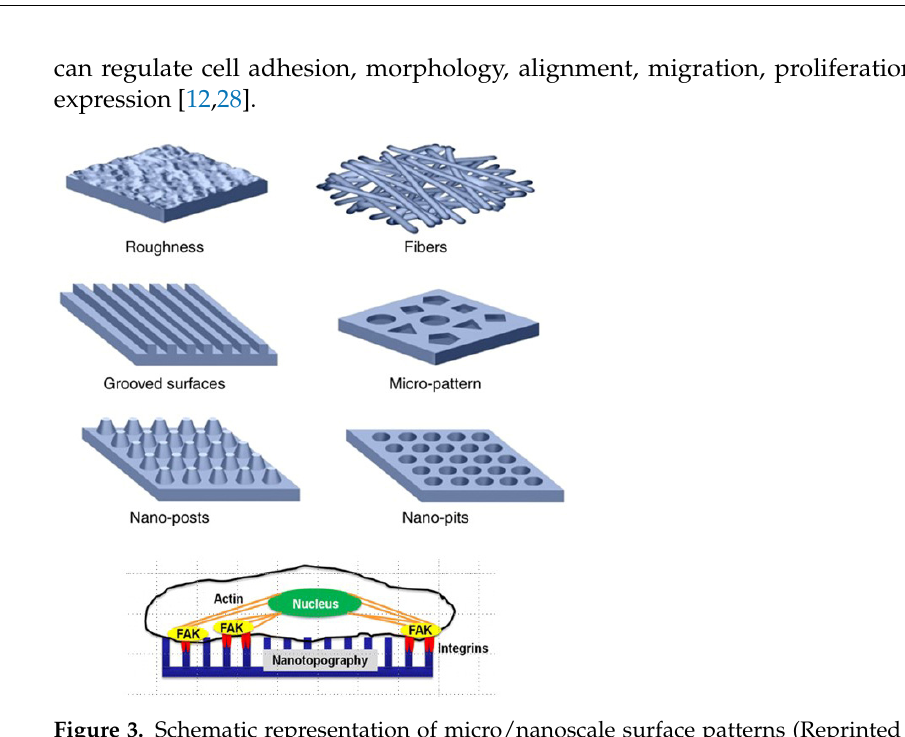
Figure 3. Schematic representation of micro/nanoscale surface patterns (Reprinted with permission from ref. [20] Copyright 2022, Elsevier and schematic representation of cell–nanotopography interactions. Adapted with permission from ref. [29] Copyright 2022 American Chemical Society.